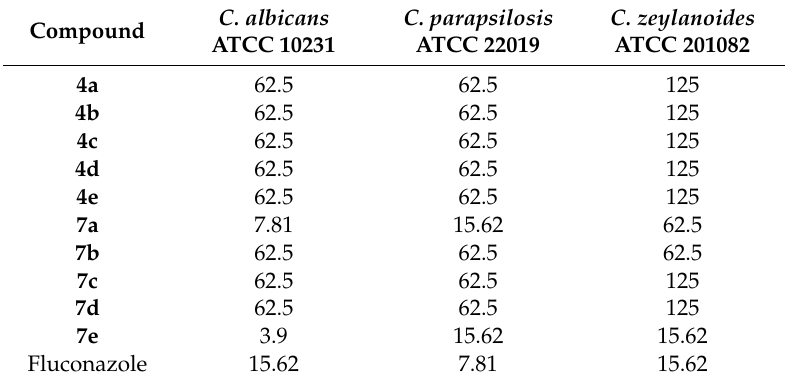
Table 2. The minimum fungicidal concentration values (MFC, µ g / mL) of the newly